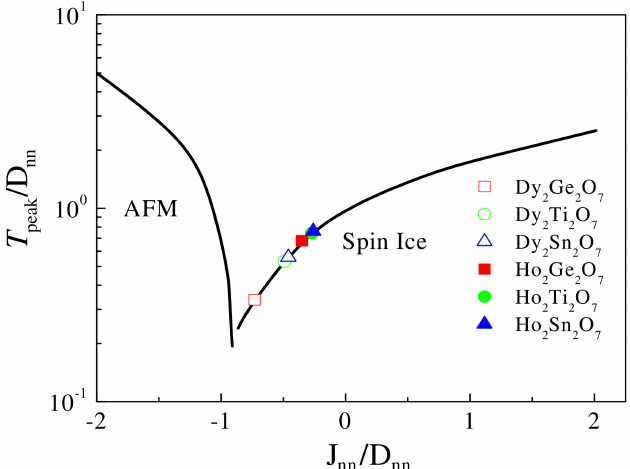
Figure 8. (color online) Dependencies of the specific heat peak position T peak / D nn on J nn / D nn ratio. The open symbols are experimental results, and the solid lines are the theoretical calculations from the dipolar spin ice model. From Ref.